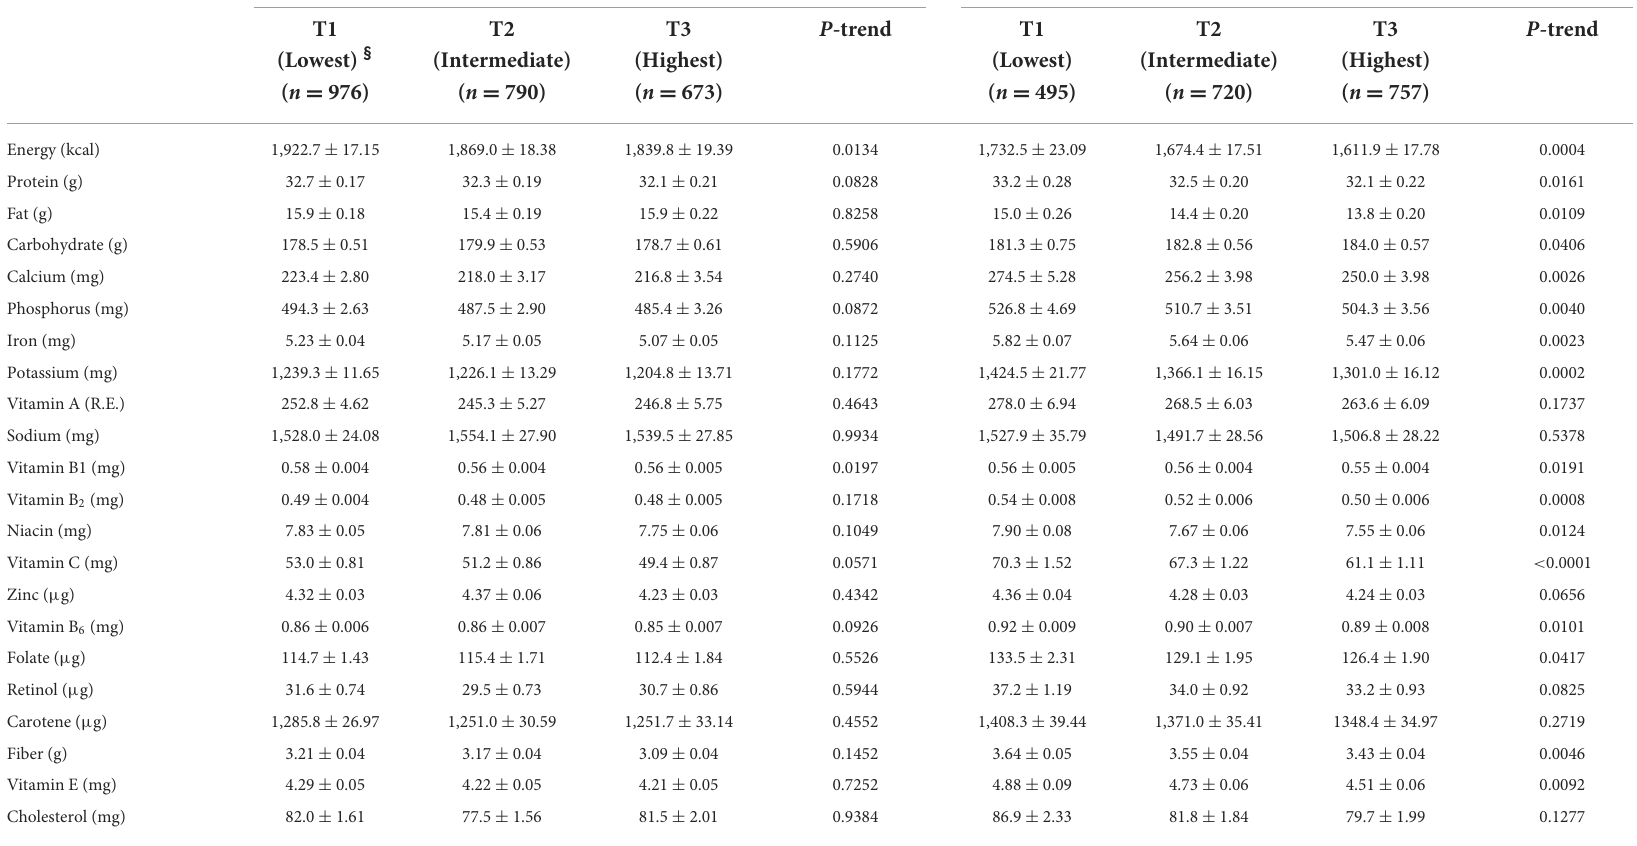
TABLE 4 Nutrient intake according to stress